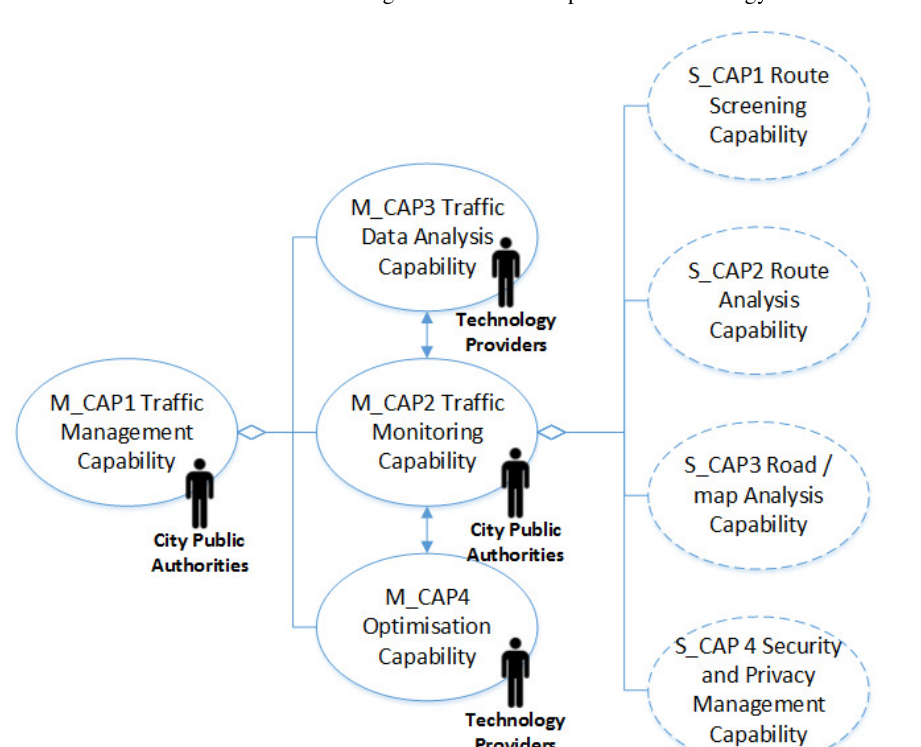
Figure 2: The overall process